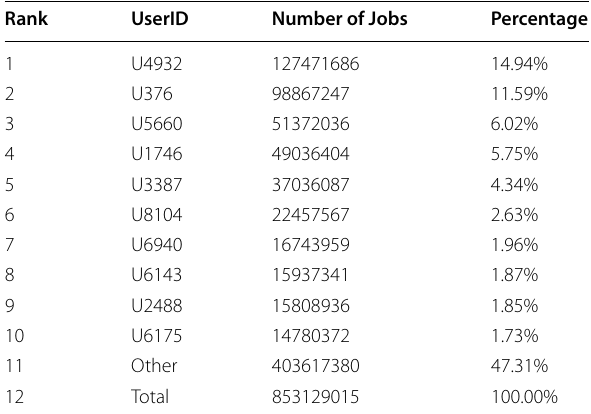
Table 1 Top 10 users by number of tasks submitted to the real